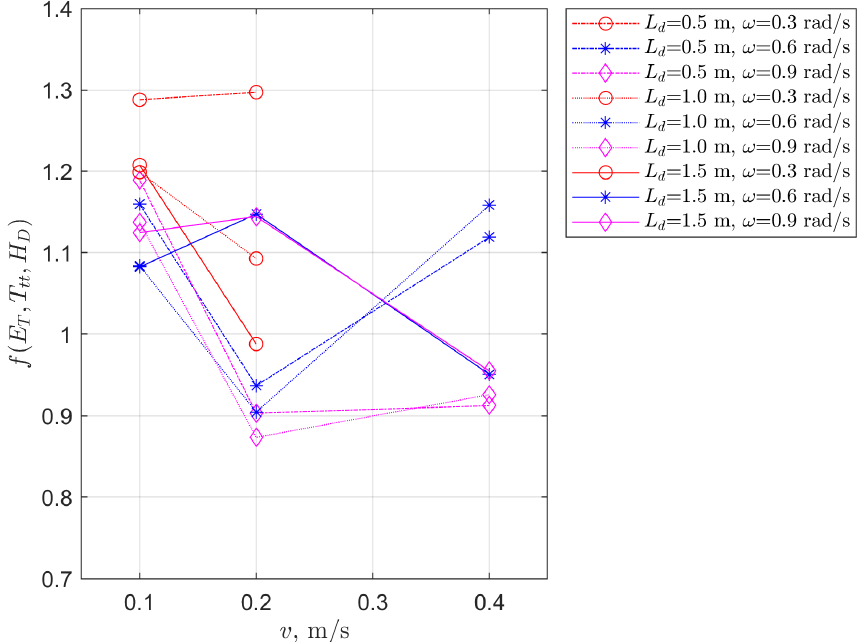
Figure 6. Cost function vs. linear speed for selected maximum values of the angular rate and look ahead distance—track